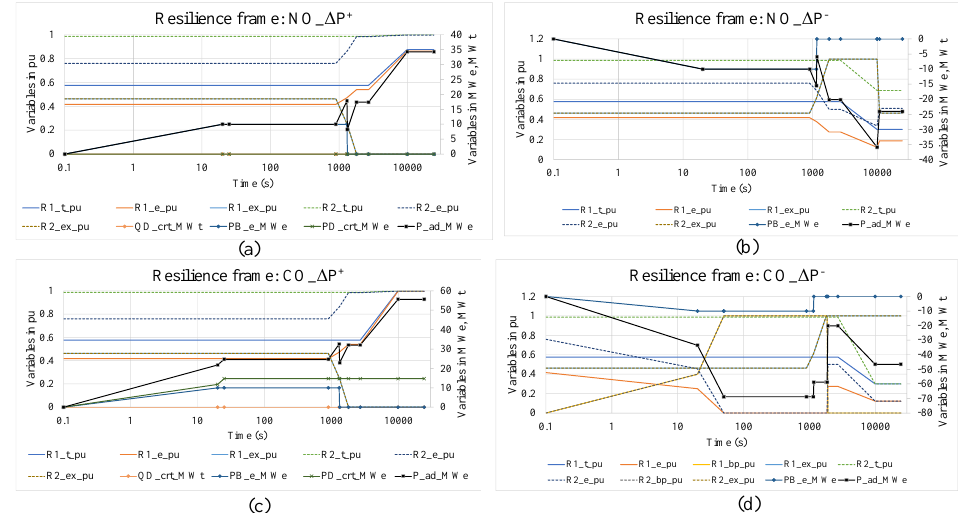
Figure 11. Resilience frames for ∆ P + and ∆ P − in NO and CO at 0 h: ( a ) NO_ ∆ P + ; ( b ) NO_ ∆ P − ; ( c ) CO_ ∆ P + ; ( d ) CO_ ∆ P − .